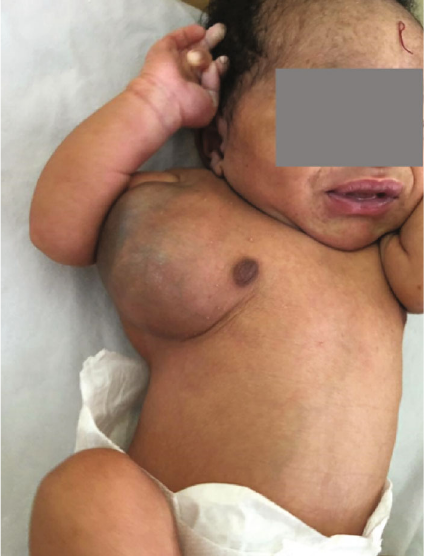
Figure 1: Photograph showing left axillary cystic hygroma.